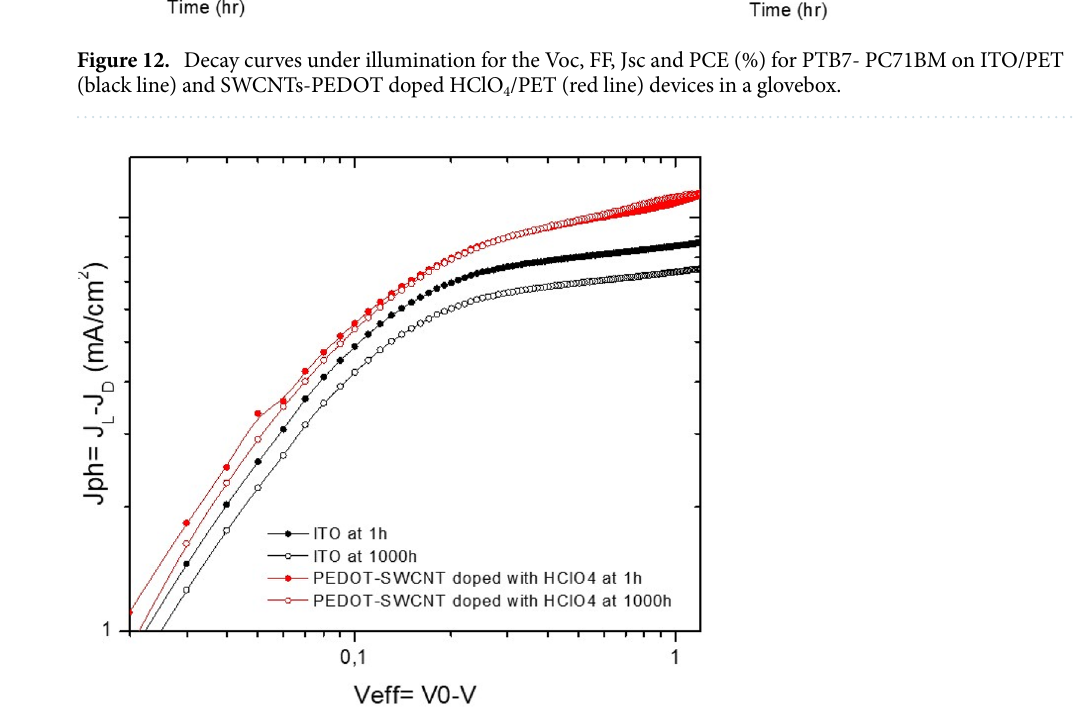
Figure 13. Experimental photocurrents after 1 h and 1000 h as a function of Veff for flexible organic solar cells based on PTB7-PC 71 BM on ITO as a reference (black curves, circular symbol) and on PEDOT-PSS: SWCNTs doped with HClO 4 (red curves, circular